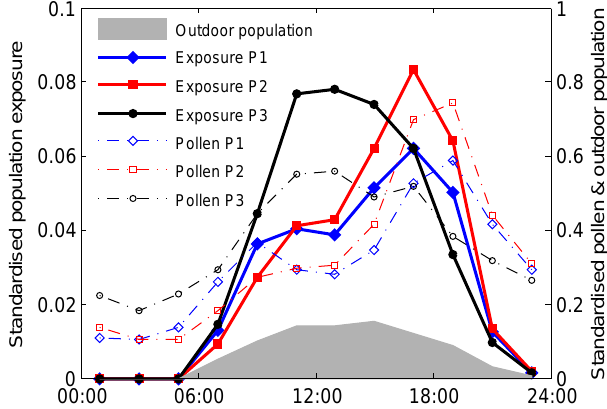
Fig. 4. Mean diurnal standardised population exposure (solid lines) and standardised pollen concentration (dotted lines) profiles for Pe- riod 1 (P1), Period 2 (P2) and Period 3 (P3). The outdoor population profile (solid), derived from the results of Klepeis et al. (2001), is also